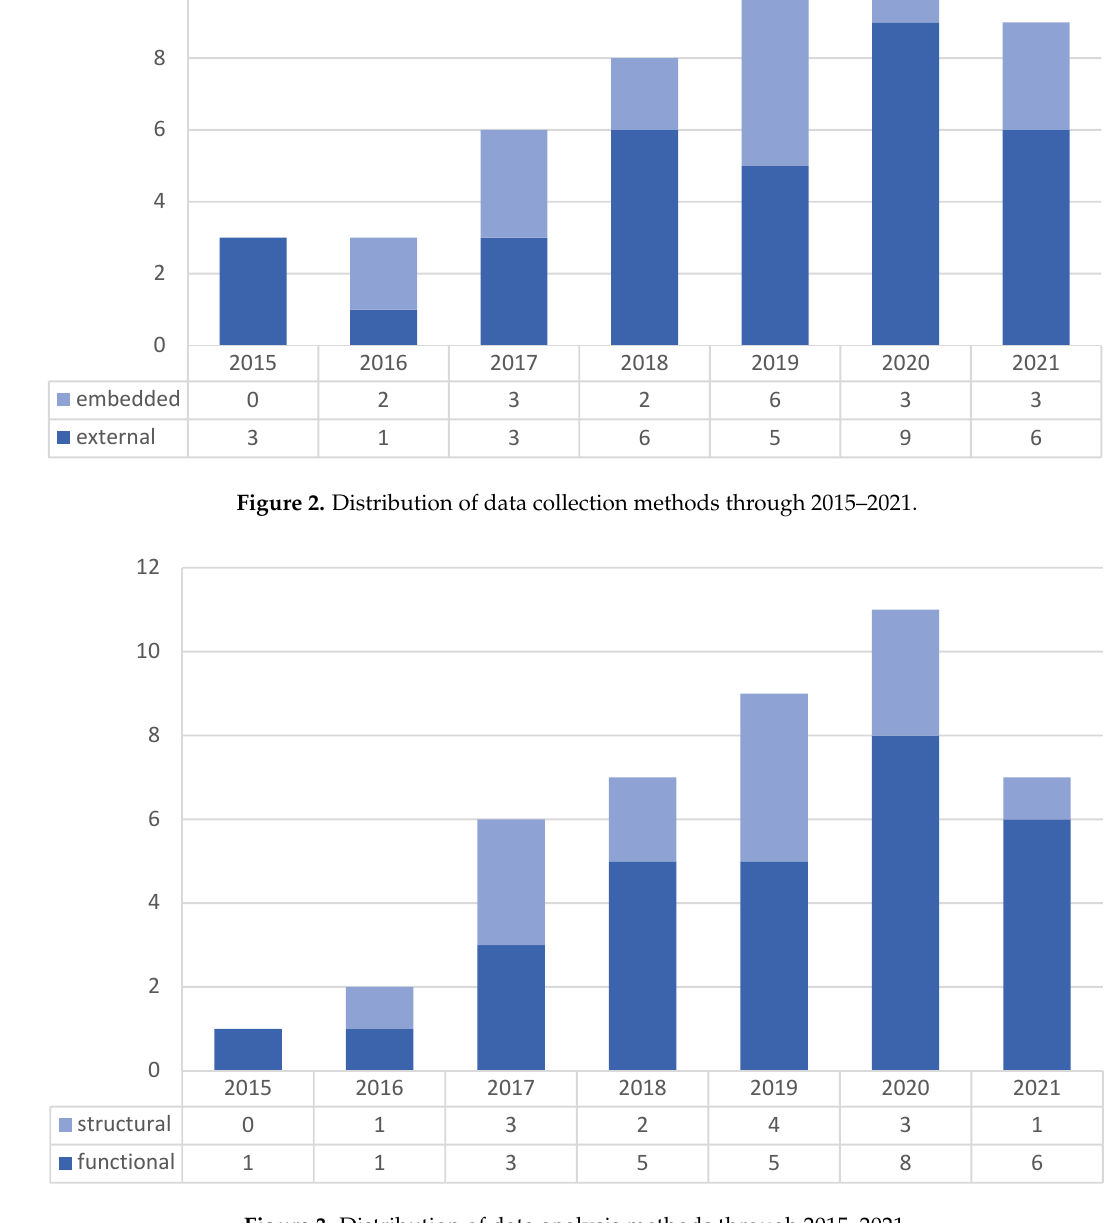
Figure 3. Distribution of data analysis methods through 2015–2021.